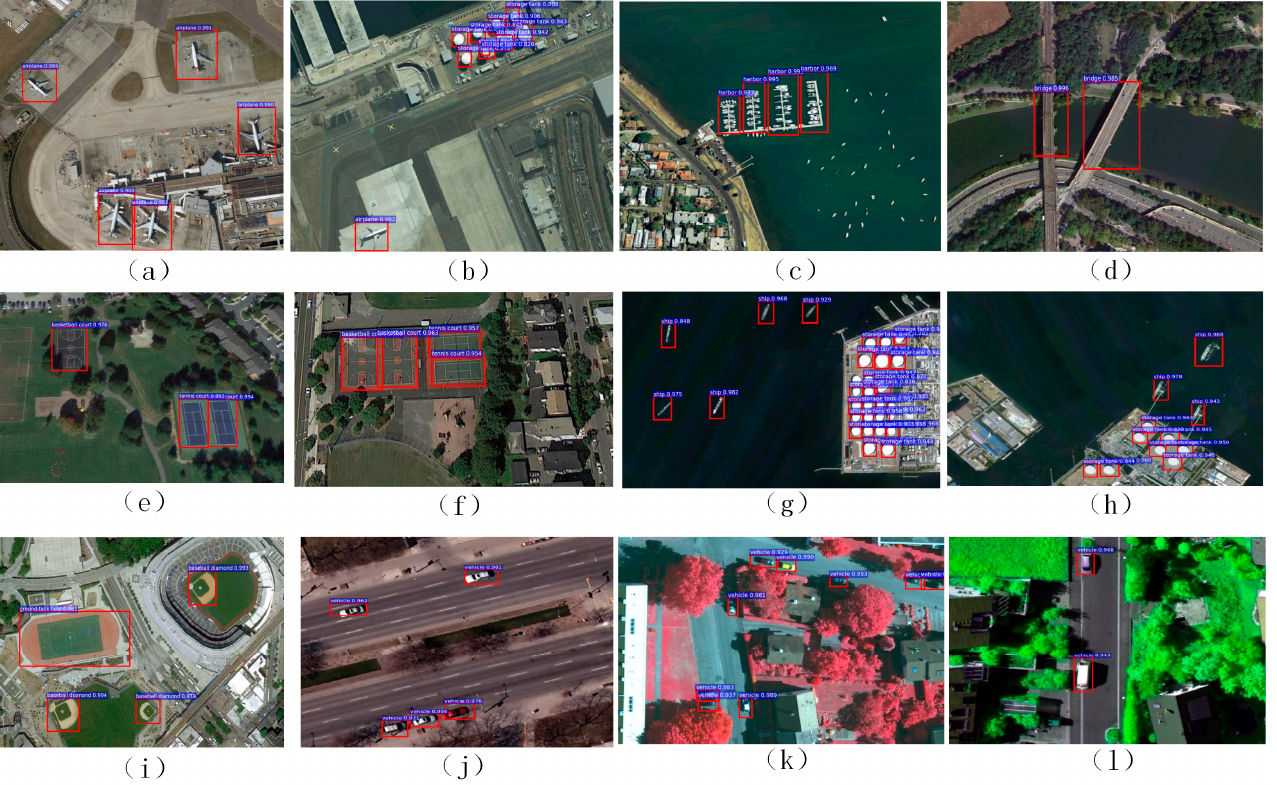
Figure 9. Some target detection results with the proposed approach.